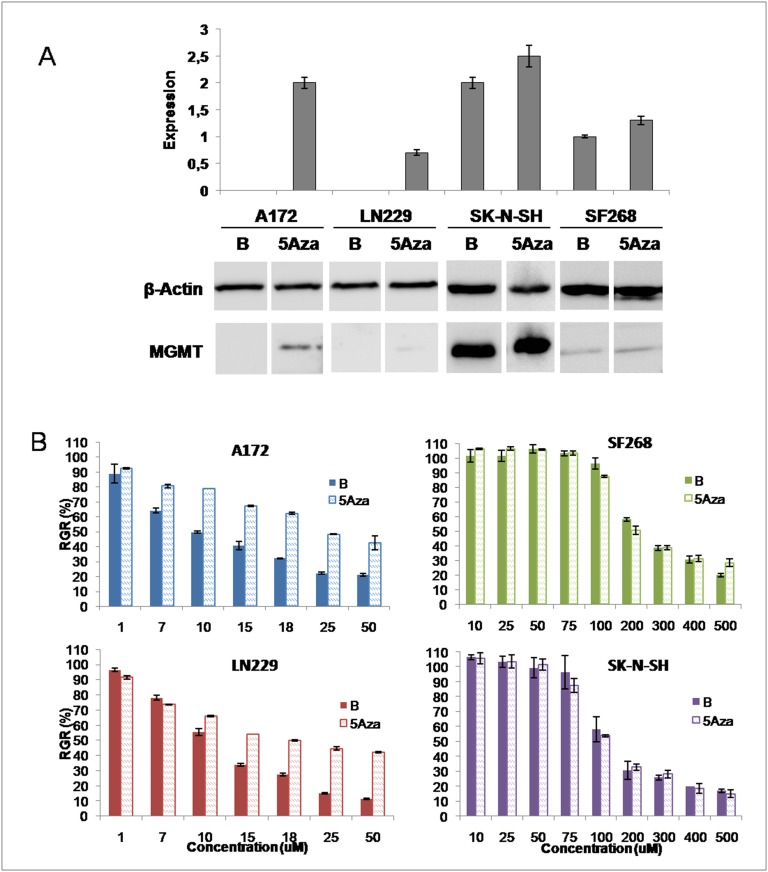
Modulation of MGMT expression by 5-Aza.A) Densitometric analysis of the effect of 5-Aza for each cell line showing relative expression of MGMT compared with beta-actin under each experimental condition. Western blot analysis of MGMT expression after 5-Aza exposure in tumor cell lines. Beta-actin expression was used as a control. B) Relative growth rates of tumor cell lines before and after 5-Aza exposure. B: basal cells, 5Aza: cell line treated with 5-Aza. All data represent the mean value ± SD of triplicate cultures.